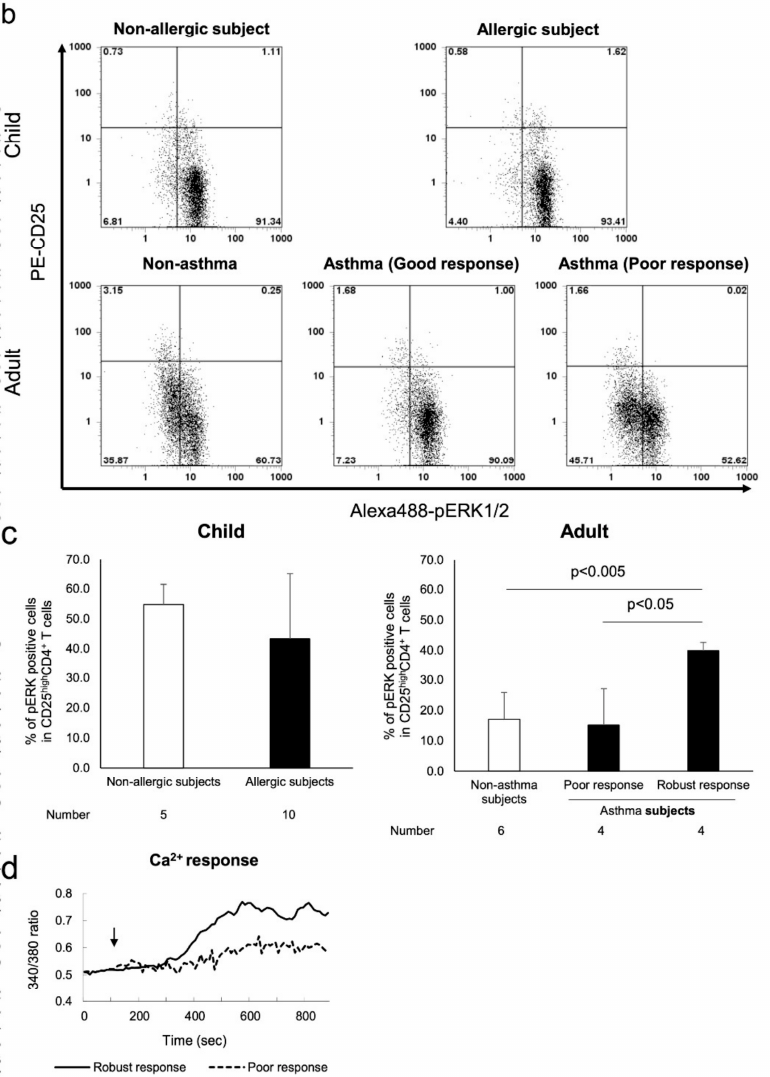
Figure 3. Flow cytometric measurement of ERK1/2 phosphorylation by H 2 O 2 exposure in CD4 + CD25 high T cells from paediatric subjects without allergy and adult subjects without asthma that were exposed to 10 mM H 2 O 2 were stained with PC5-CD4, PE-CD25, and Alexa 488-pERK1/2. The representative flow histograms are shown in ( a ). The typical patterns of pERK1/2 expression among all child subject groups are shown in ( b ). The average percentage of pERK1/2- positive cells in all adult subject groups were plotted by bar graphs, and asthma subjects were further divided into two groups by Ca 2+ response ( c ). Typical patterns (poor response and robust response) of Ca 2+ response are depicted in ( d ). Gating was performed on cells highly expressing CD25